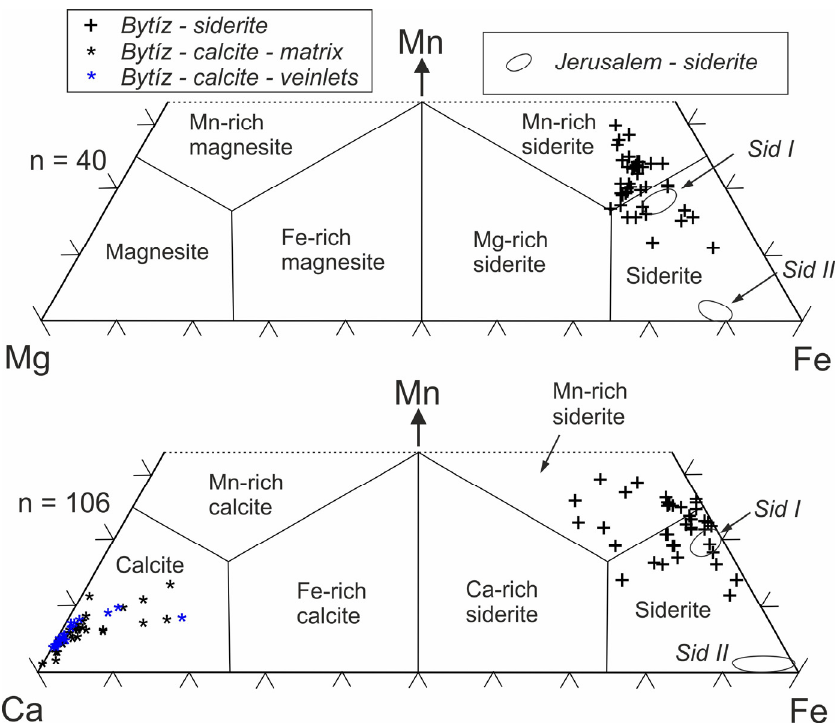
Figure 22. Chemical composition of calcites and siderites from Bytíz in the Mg-Fe-Mn plot and the Ca-Fe-Mn plot (modified from Trdli č ka, Hoffman [84]. Comparative data are from Sejkora et al. [4].